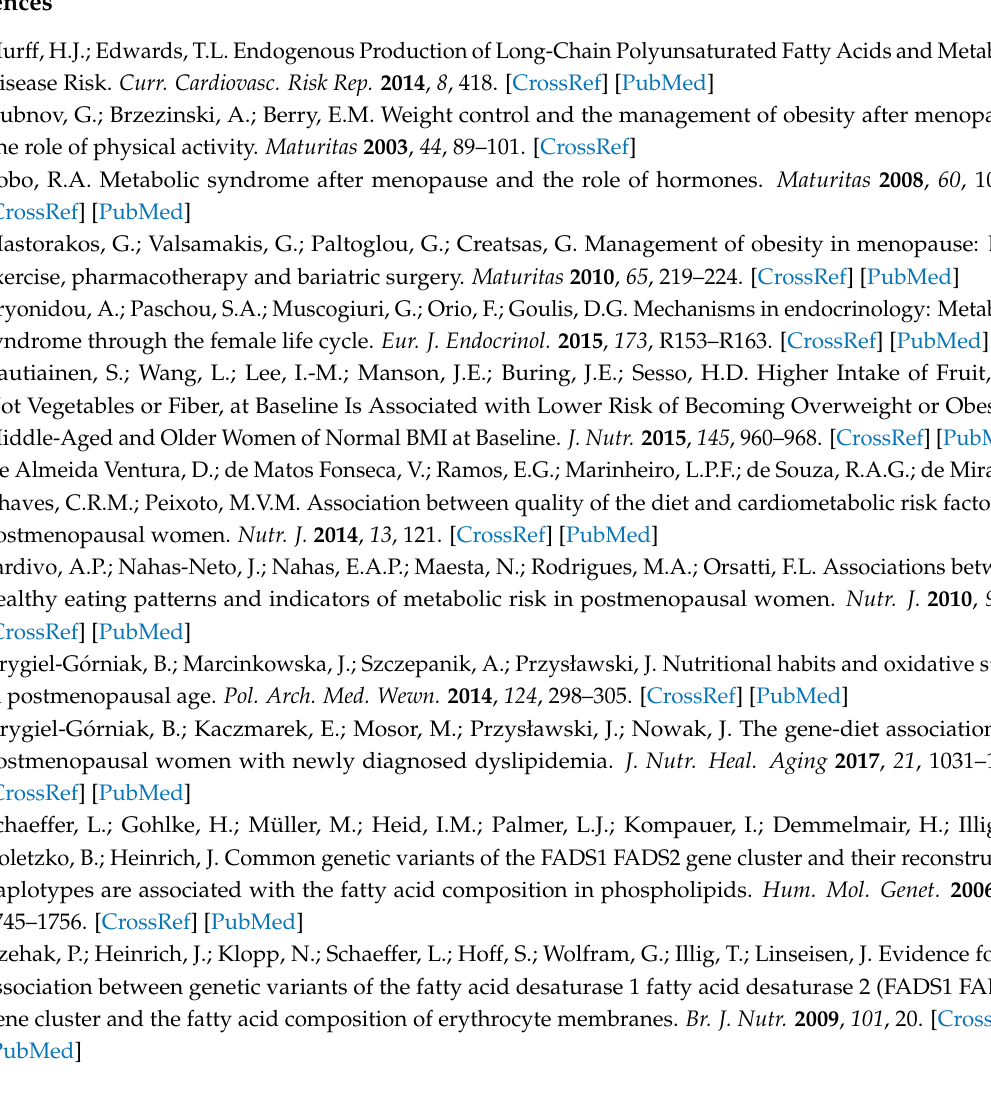
s1, Table S1: Distribution of erythrocyte fatty acids by median total SFA intake, Table S2: Distribution of erythrocyte fatty acids by median total MUFA intake, Table S3: Distribution of erythrocyte fatty acids by median total PUFA